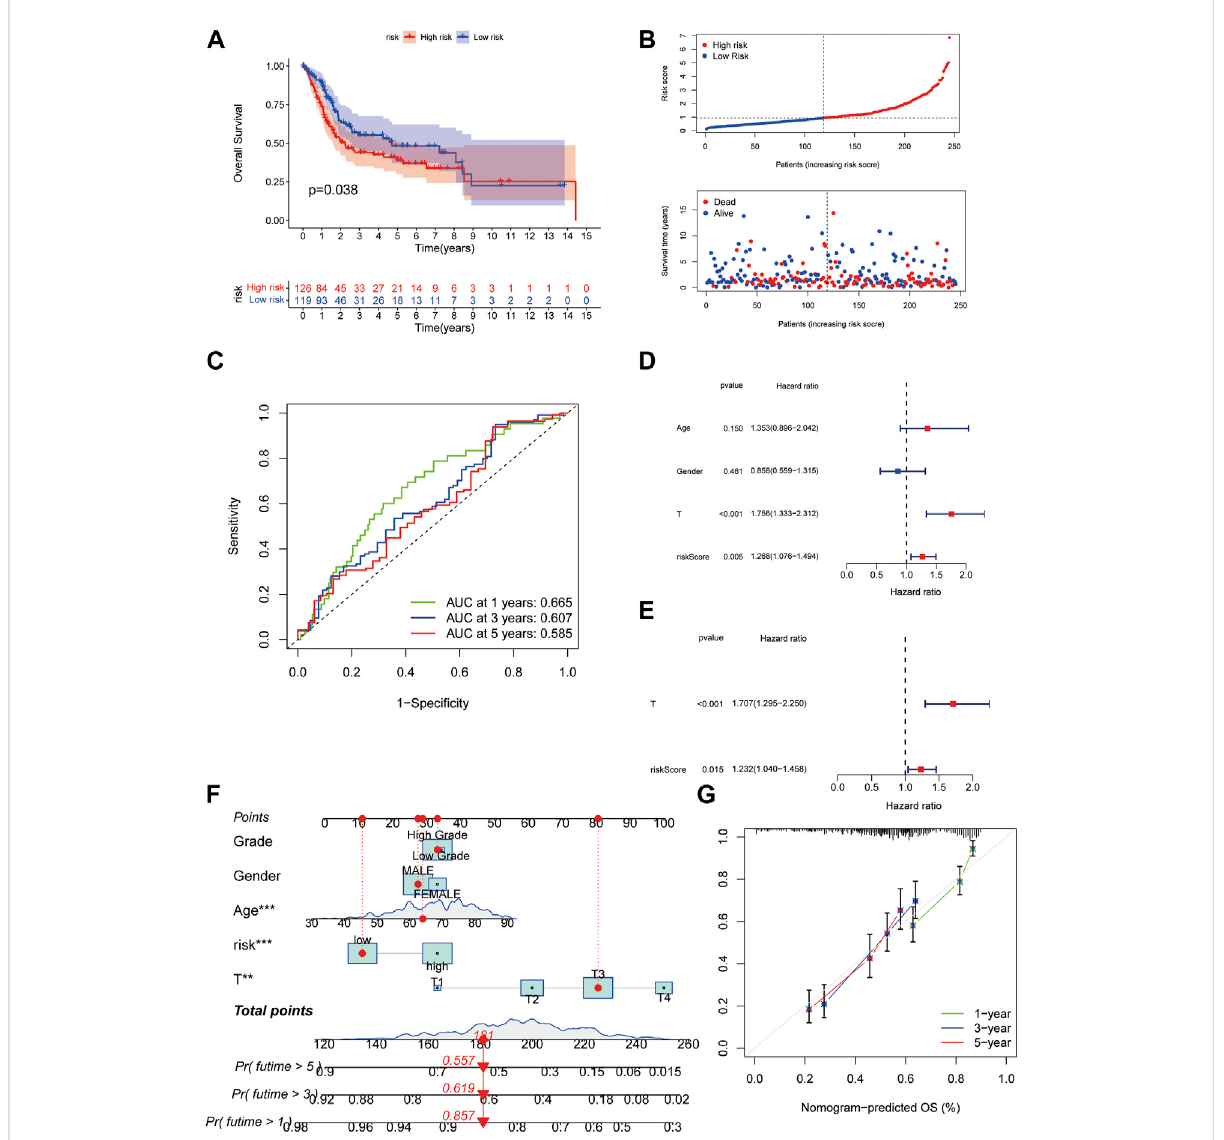
FIGURE 6 Validation of the cuproptosis scoring system for BLCA. (A) Kaplan-Meier survival analysis for patients in high- and low-risk groups in the validation cohort. (B) The distribution of the risk scores, OS statues, and the correlations between OS and risk scores. (C) ROC curve of the cuproptosisriskscoringsystemforpredictionofOSinthevalidationcohort. (D) ResultsoftheunivariateCoxregressionanalysesregardingOSinthe validation cohort. Theriskscore wassigni fi cantly associated withtheOS. (E) Resultsofthemultivariate CoxregressionanalysesregardingOS in the validation cohort. The risk score was an independent prognostic factor. (F) Nomogram for the prediction of 1-,3-, 5-years survival probability in patients with BLCA. The red line showed the score of one patient as an example. (G) Calibration curves of nomograms in terms of the agreement between predicted and observed 1-, 3-, and 5- years OS. Abbreviations: OS, overall survival; ROC, receiver operating characteristic; BLCA, bladder